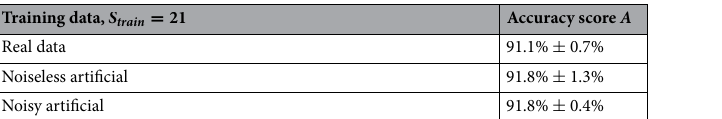
Table 1. Comparison of model accuracy for different types of training data: real images, artificial noiseless images, and artificial images with noise added as a post-processing filter.